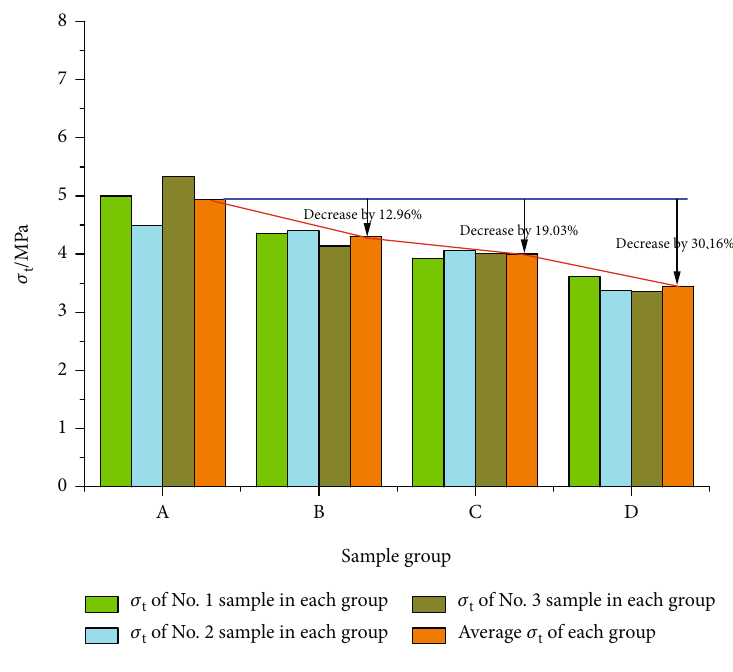
Figure 4: Comparison of sandstone sample tensile strengths.